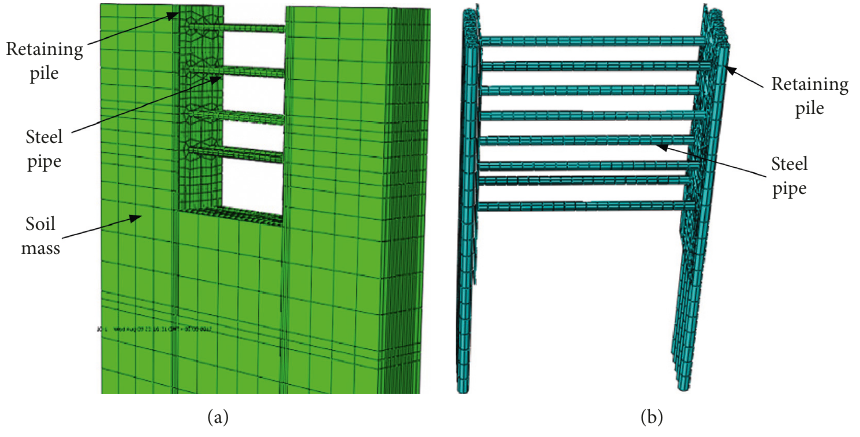
Figure 6: Numerical model: (a) overall model and (b) the supporting